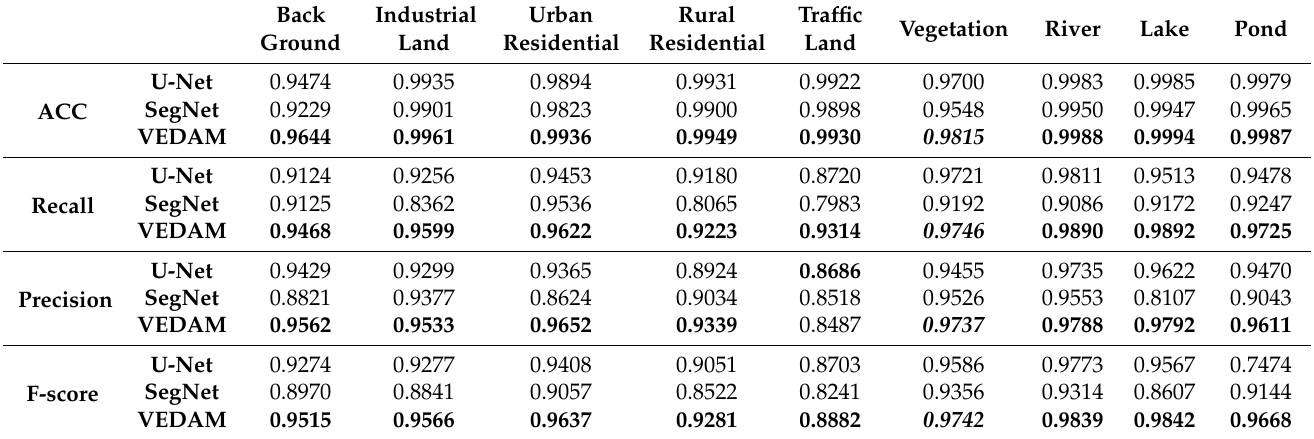
Table 4. Comparison results of U-Net, SegNet, and VEDAM on the GID